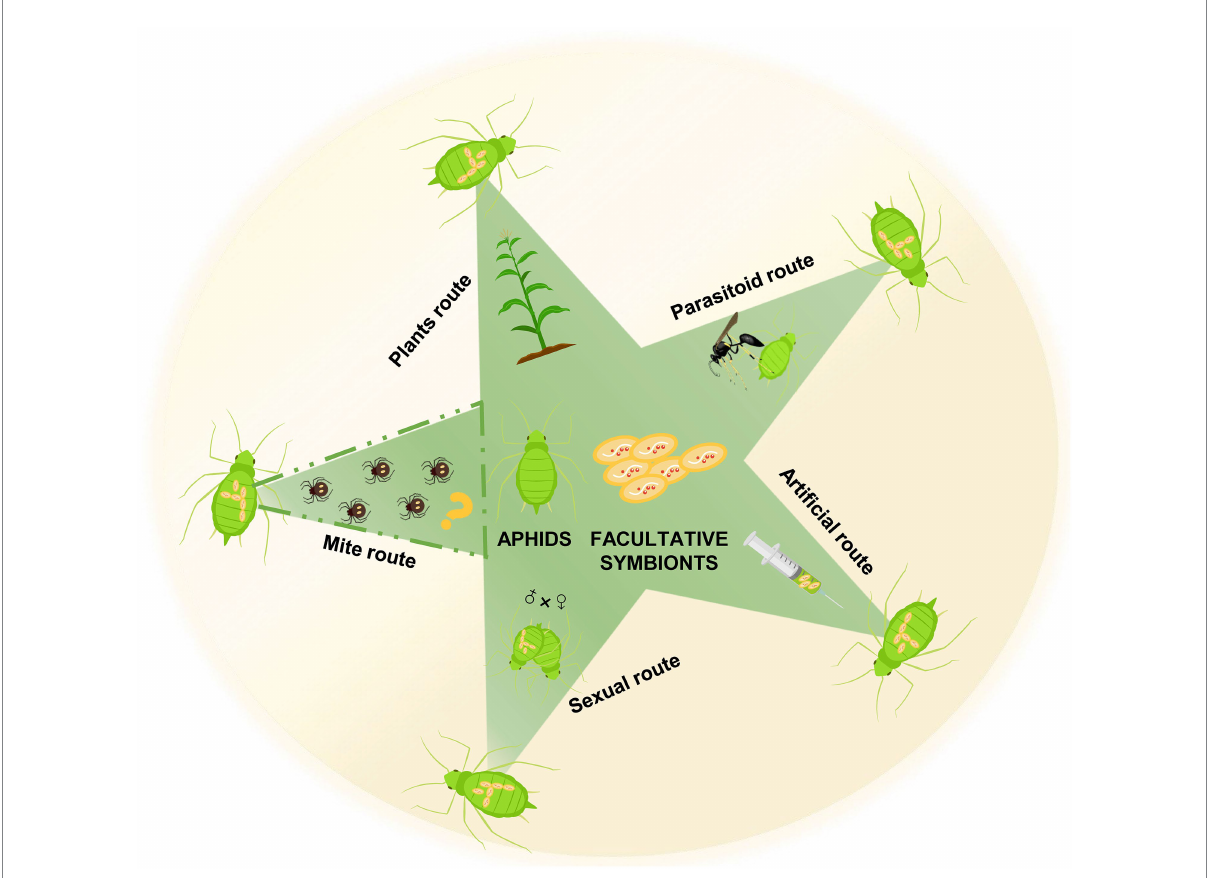
FIGURE 2 The potential horizontal transmission routes of aphid facultative symbionts. The question mark indicates that it is not clear whether aphid facultative symbionts can be horizontally transmitted by mites, though this route is often